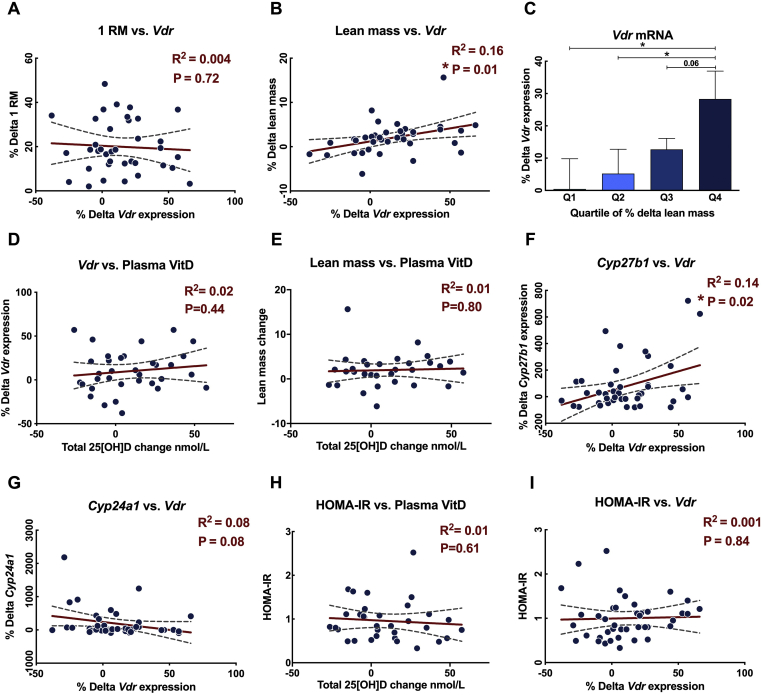
VDR expression in humans correlated with increases in lean mass from RET. (A) % Δ 1-RM vs. % Δ Vdr (n = 37). (B) % Δ Lean mass vs. % Δ Vdr (n = 37). (C) VDR expression in quartile groups of changes in lean mass. (D) % Δ 1-RM vs. Δ Plasma Vitamin D (n = 37). (E) % Δ Lean mass vs. Δ Plasma Vitamin D (VitD) (n = 37). (F) % Δ Cyp27b1 vs. % Δ Vdr (n = 37). (G) % Δ Cyp24a1 vs. % Δ Vdr (n = 37). (H) Post training HOMA-IR vs. Δ Plasma VitD (n = 37). (H) Post training HOMA-IR vs. % Δ Vdr (n = 37). (J) Representation of VitD metabolism. All % Δ changes are between pre- and post-training. Column data are mean ± SEM. ∗p < 0.05 between indicated groups.